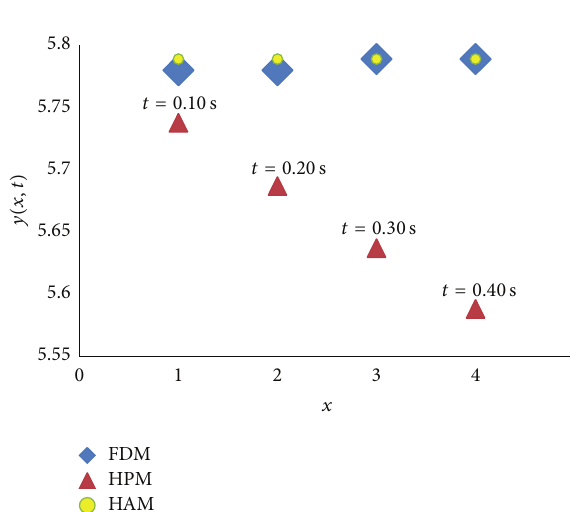
Figure6:ThecomparisonofHPM,HAM,andFDMforthesolution 𝑦(𝑥,𝑡) for different values of 0 ≤ 𝑥 ≥ 4 and 0 ≤ 𝑡 ≥ 0.4 ; ℏ = 0.001